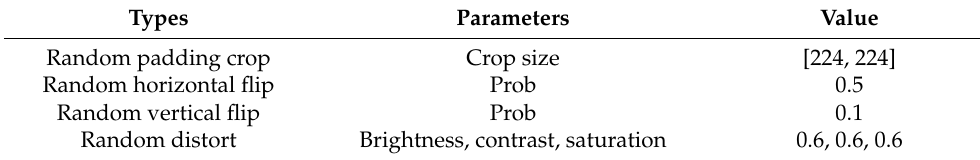
Table 1. Types and settings of data